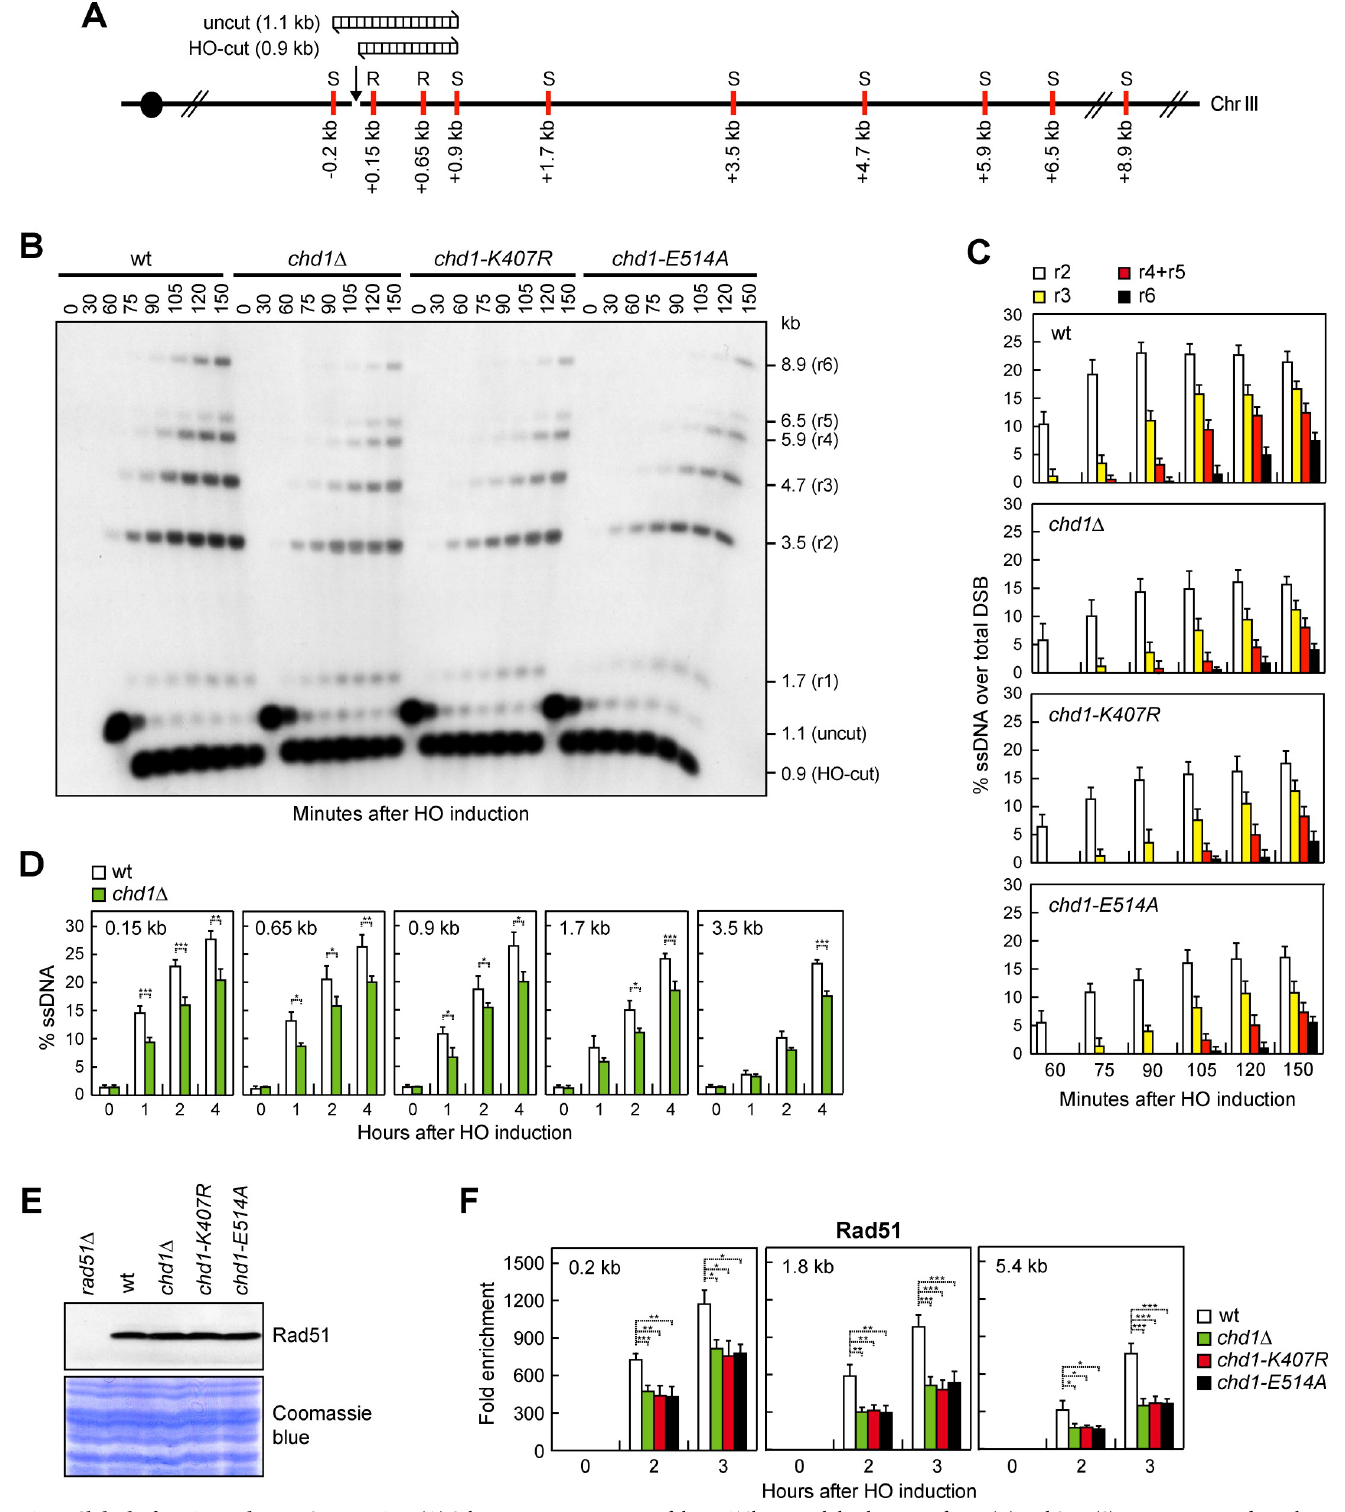
Fig 2. Chd1 dysfunction reduces DSB resection. (A) Schematic representation of the MAT locus and the distance of RsaI (R) and SspI (S) restriction sites from the HO-cut site. The DNA fragments detected in panel B before (uncut) and after HO cleavage (HO-cut) were also indicated. (B) YEPR exponentially growing cell cultures of JKM139 derivative strains were transferred to YEPRG at time zero. Southern blot analysis of SspI-digested genomic DNA after alkaline gel electrophoresis